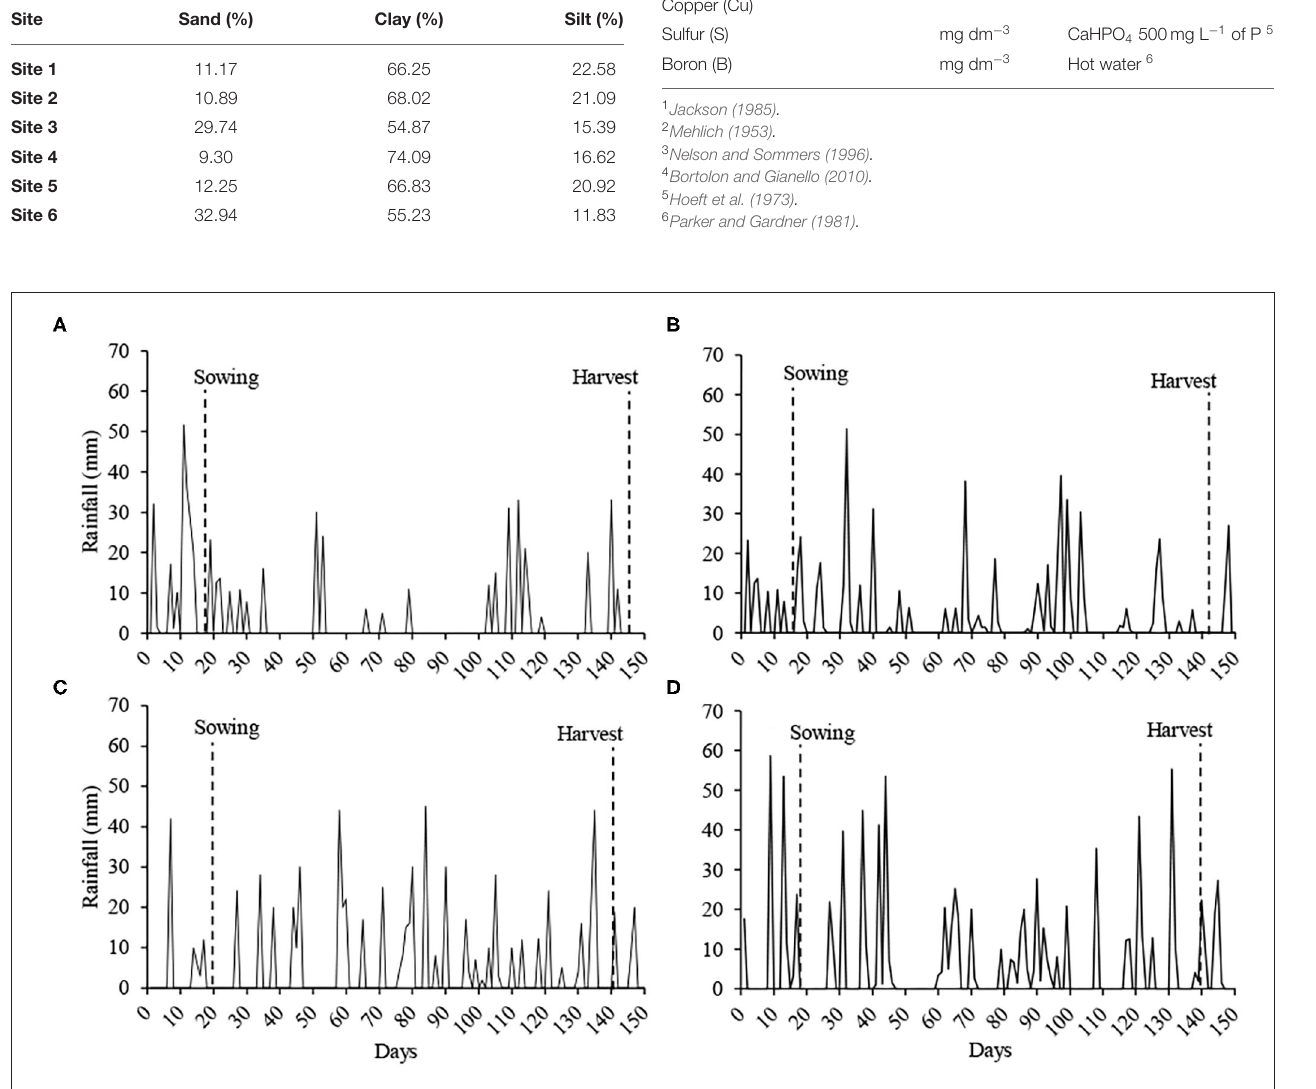
Frontiers in Plant Science |